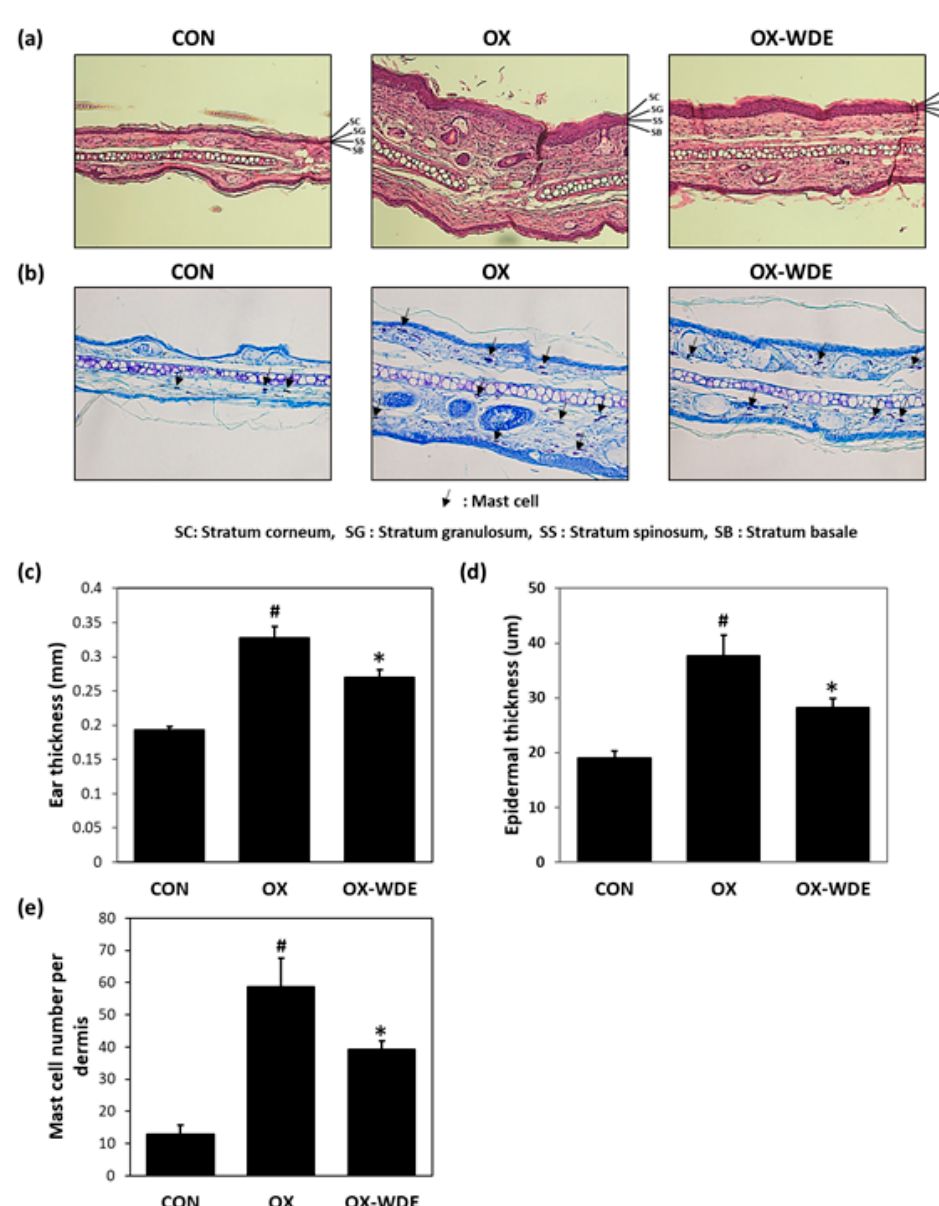
Figure 2. Effects of WDE on histopathological changes, ear thicknesses, epidermal thicknesses, and mast cell numbers on oxazolone-induced AD-like symptoms in BALB/c mouse ears. ( a ) Hematoxylin and eosin (H&E) staining. ( b ) Toluidine blue staining. ( c ) Ear thicknesses. ( d ) Epidermal thicknesses. ( e ) Mast cell numbers. Results are expressed as the means ± SEMs ( n = 7) of two independent experiments performed in triplicate. # p < 0.05 vs. the CON group; * p < 0.05 vs. the OX group.